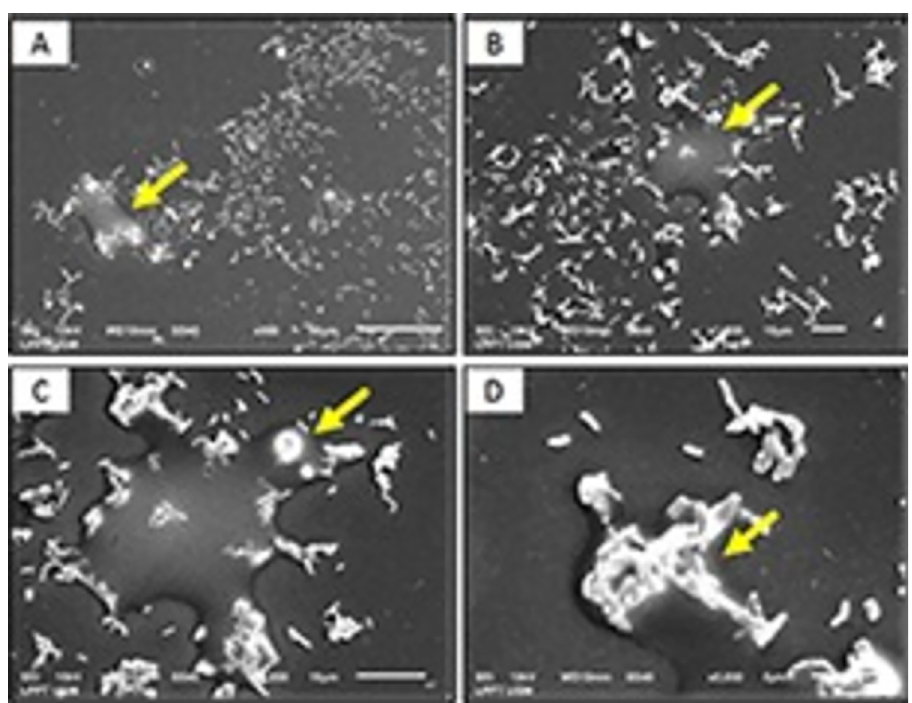
Fig 4. The cell structure of the biofilm in M . abscessus on observation by SEM on the 7 th day of incubation. Yellow arrows indicate extra-cellular polymer substance (EPS) formation. (A) Observation at 500 × magnification. (B) Observation at 1000 × magnification. (C) Observation at 2000 × magnification. (D) Observation at 5000 × magnification.